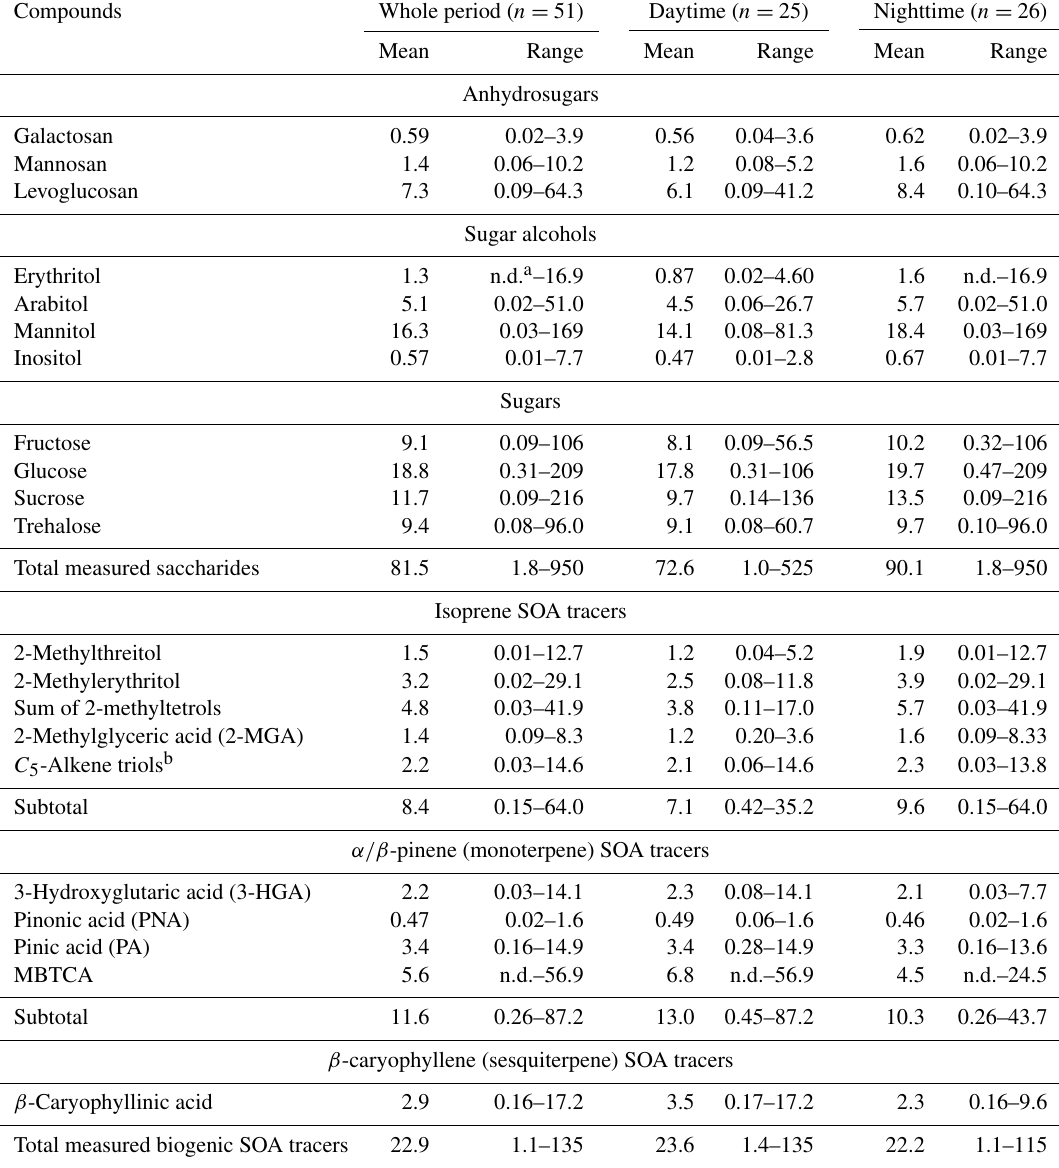
Table 1. Concentrations (ngm − 3 ) of saccharides and biogenic SOA tracers measured in the marine aerosols collected over the East China Sea during May to June